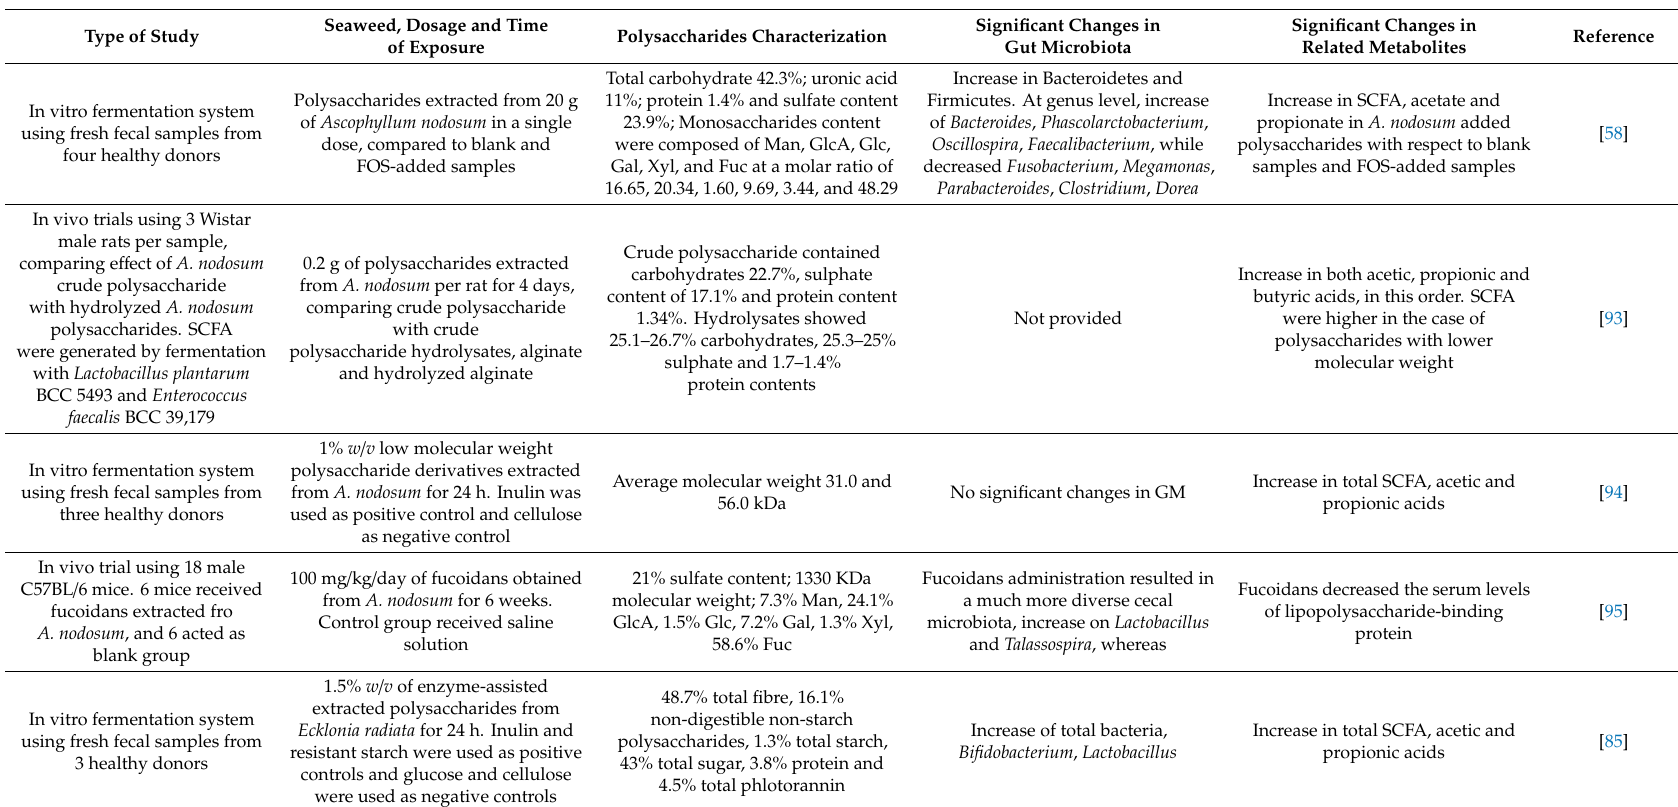
Table 1. Prebiotic e ff ect of di ff erent species of brown